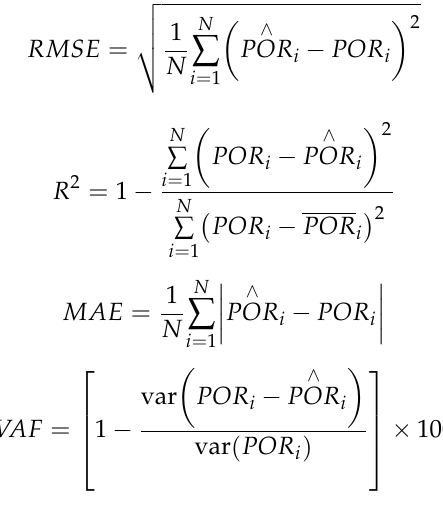
Figure 5. Correlation between parameters based on Spearman algorithm.